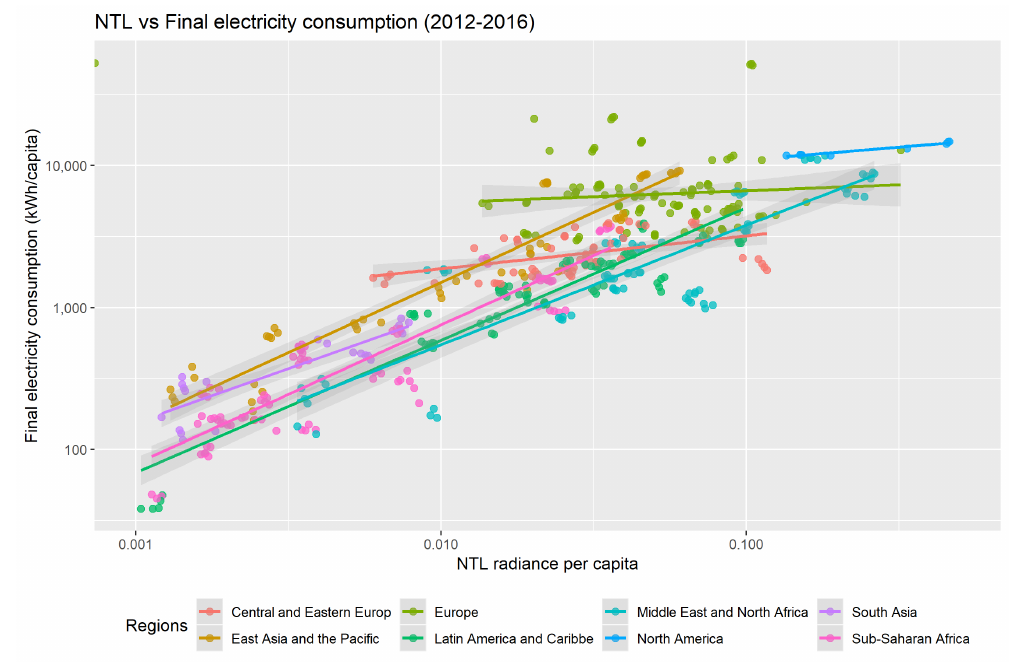
Figure 6. NTL vs. TFC by region (average values